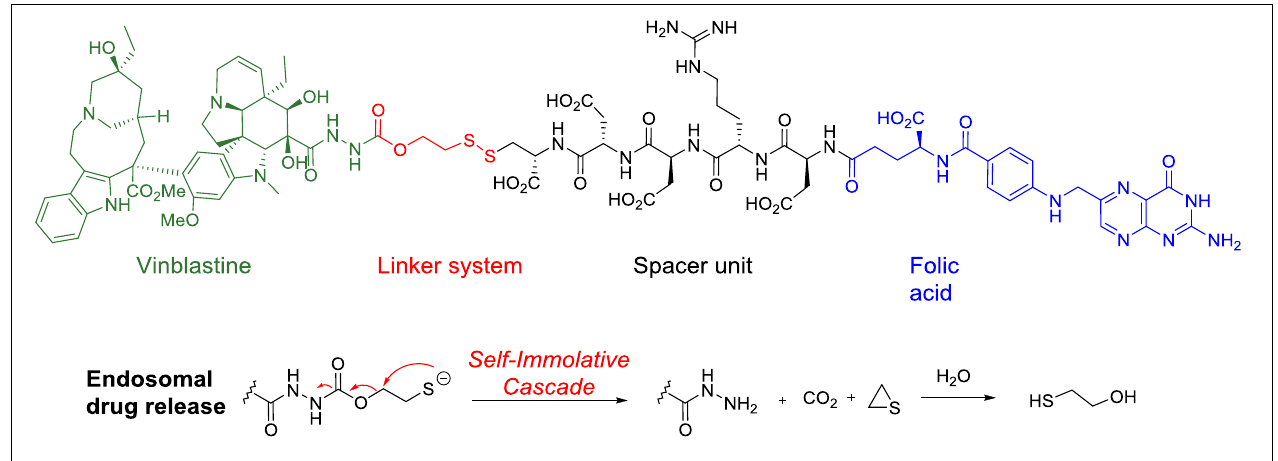
FIGURE 8 | Structure of vintafolide and mechanism of release of the payload in the